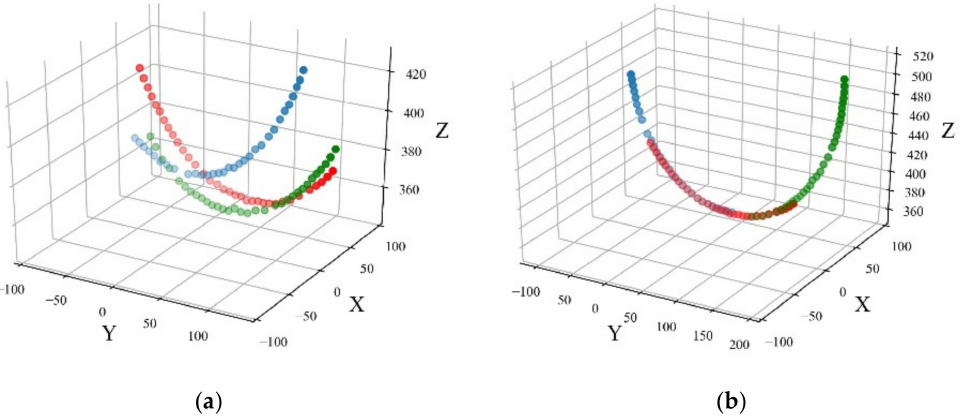
Figure 15. ( a ) Raw point clouds; ( b ) point clouds after